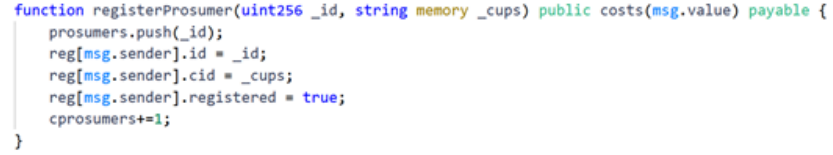
Figure 5. Example of the registerProsumer function inside one of the Smart